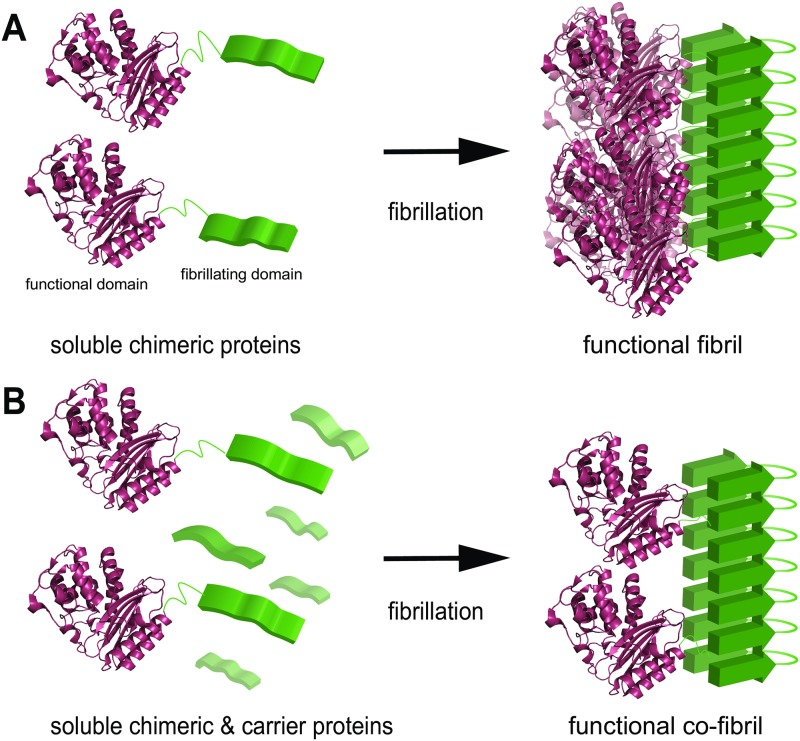
Schematic illustration of two concepts for functionalization of protein nanofibrils.(A) An unstructured domain (green, left) that is prone to refold and assemble into cross-β structured protein nanofibrils (green, right) is genetically fused to a functional domain, e.g. an enzyme (purple, the β-lactamase TEM1 from E. coli. PDB accession code 4OQG). The chimeric proteins can fibrillate into fibrils that display the functional domains. However, the dense packing can lead to steric restrictions and at least partial loss of the function. (B) Fibrillation of the chimeric proteins together with carrier proteins, i.e. the fibrillation domains, creates functional co-fibrils. Since the carrier proteins do not occupy space on the surface of the fibril, the accessibility to the functional domains is not confined and the functionality is retained.